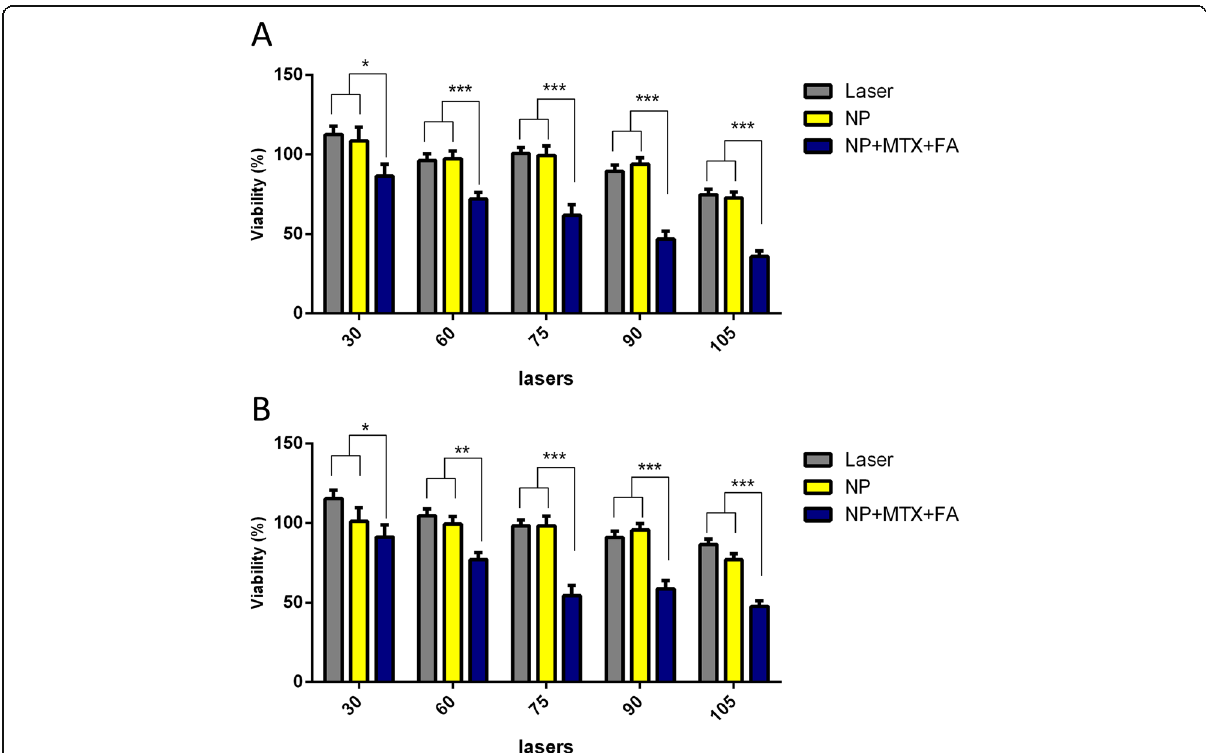
Fig. 7 A comparison of cell growth inhibition rates exposed to different laser powers (30, 60, 75, 90 and 105 J/cm 2 ) for treatment groups of laser alone, laser + Au@SiO2 nanoparticles and laser + MTX-FA loaded Au@SiO2 nanoparticles directed for two cell line MCF-7 ( a ) and MDA-MB-231( b ) with subsequent checking after